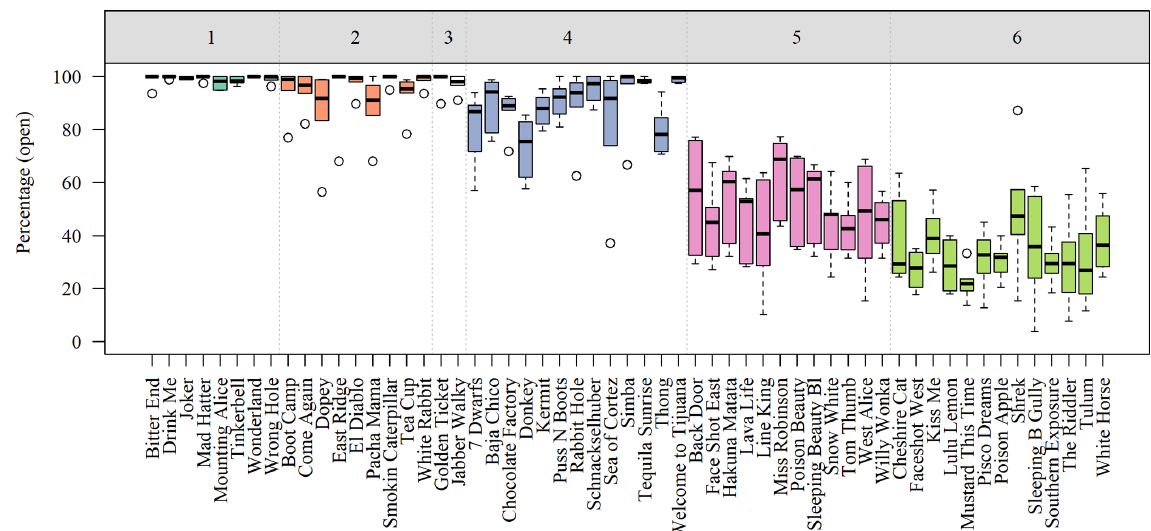
Figure 3. Boxplot of average seasonal percentages of run code “open” for the 57 ski runs during the six seasons 2012/13 to 2017/18 with the six identified classes of similarly managed ski runs (Sterchi and Haegeli, 2019). Due to the small group size and their outlier characteristics, the two runs of Class 3 were not included in the present